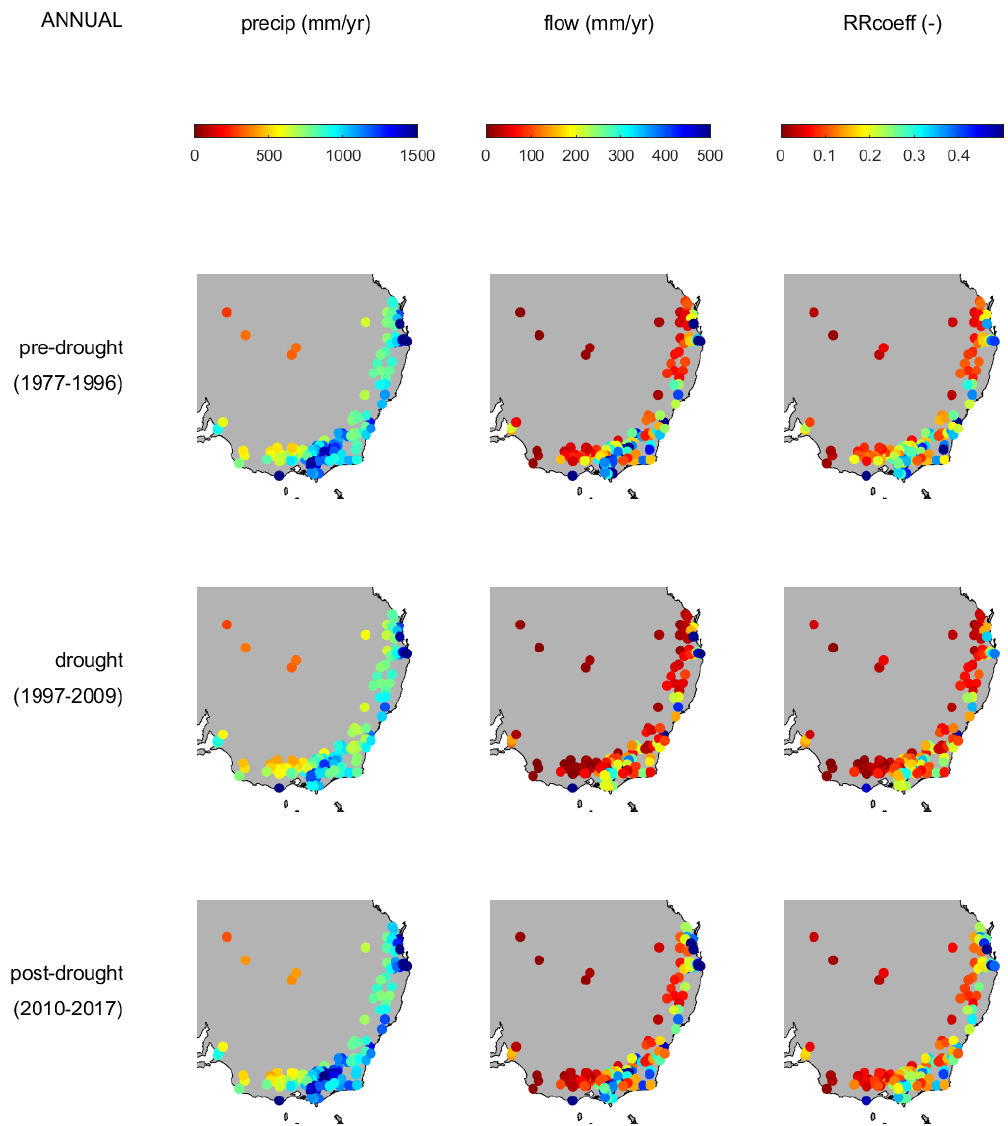
Figure B1. Maps of precipitation, streamflow, and runoff coefficient over various periods, based on annual averages. Data from Fowler et al.